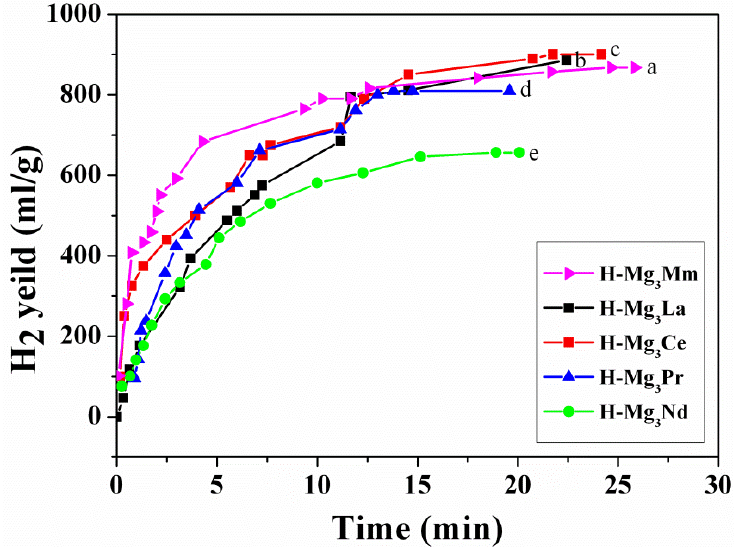
Figure 3. The hydrogen evolution curves for the hydrolysis of (a) H-Mg 3 Mm; (b) H-Mg 3 La; (c) H-Mg 3 Ce; (d) H-Mg 3 Pr and (e) H-Mg 3 Nd alloys at 298 K [67]. Reproduced